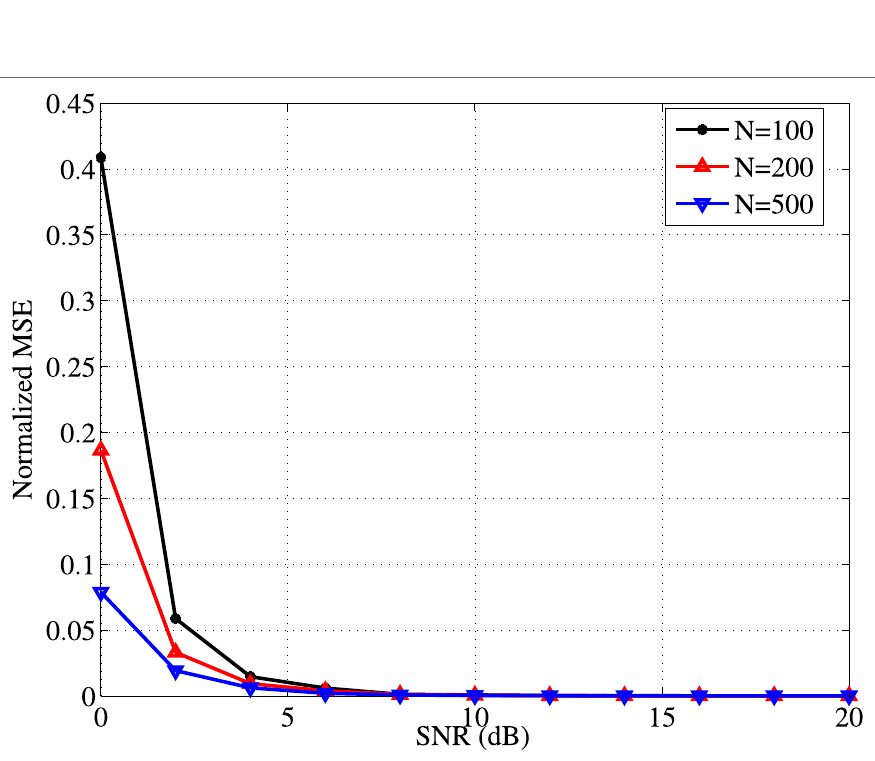
Fig. 4 The NMSE under different length of simulation symbols. N = 100, N = 200, and N = 500,